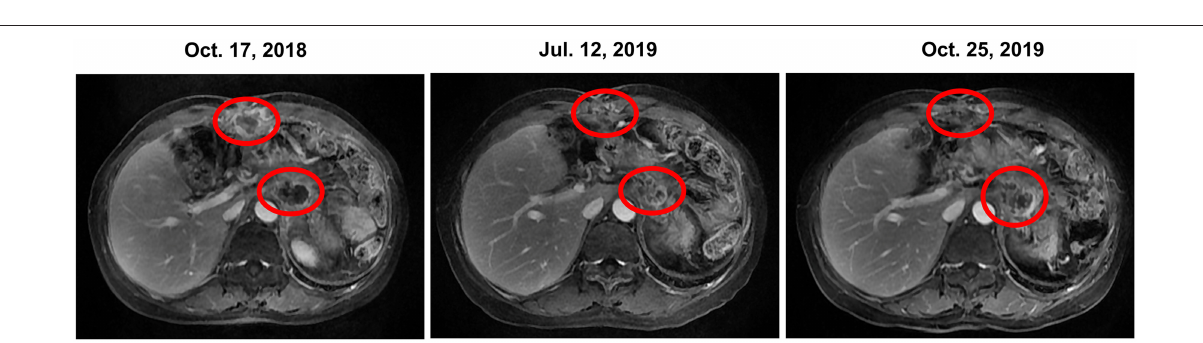
recombination and mediating DNA damage response, could cause DNA replication and damage response defects (18). In a study analyzing data from 524 families with germline